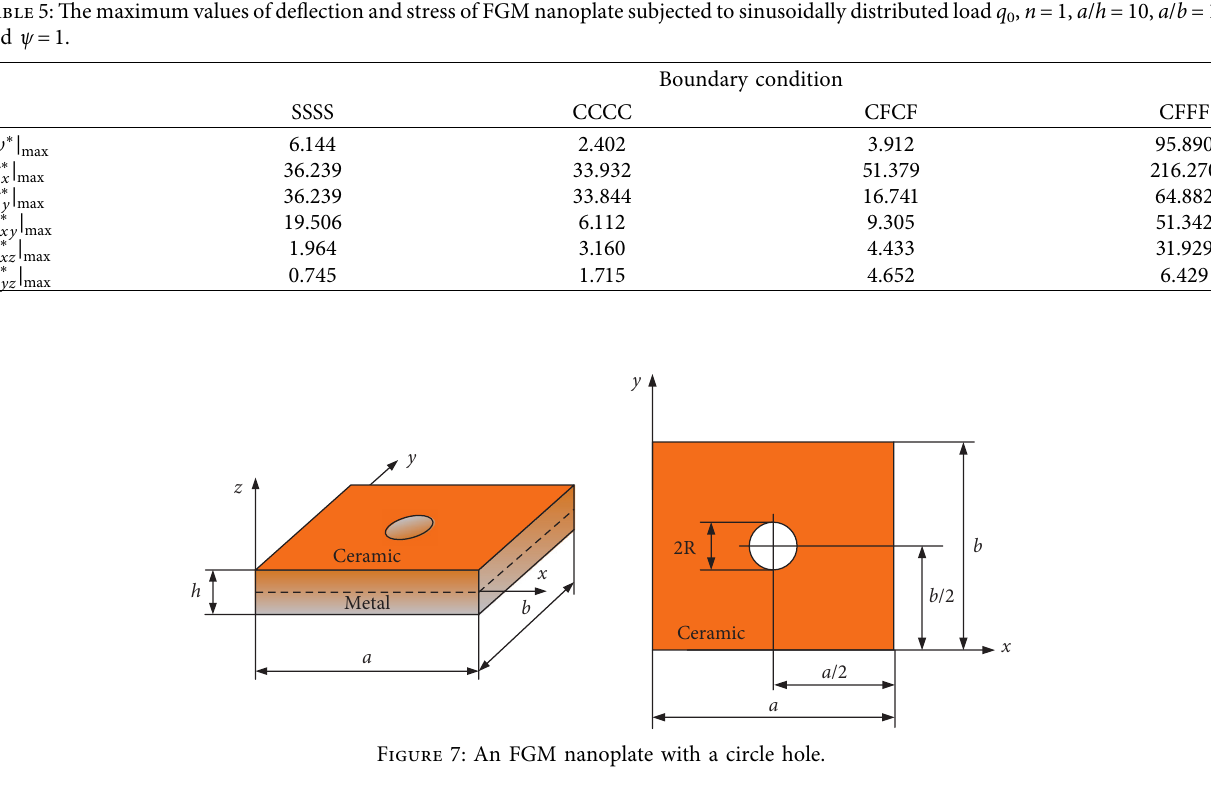
� 1, a / h � 10, a / b � 1, 0 , n